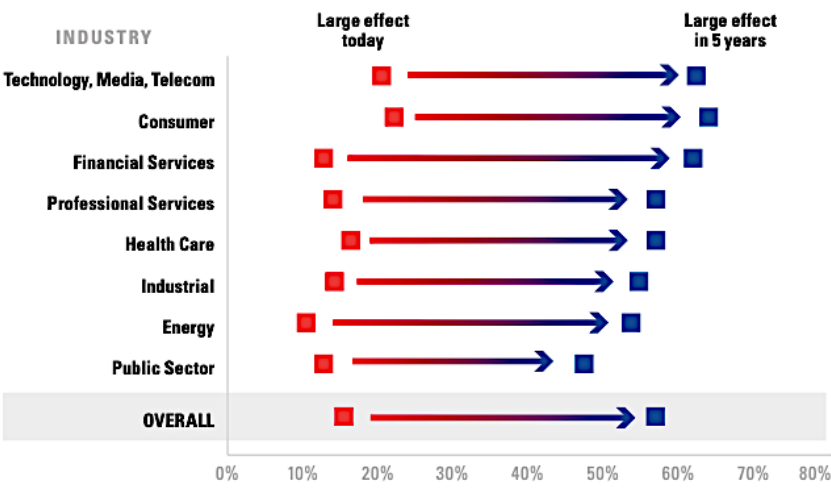
Source: MIT Sloan Management Review